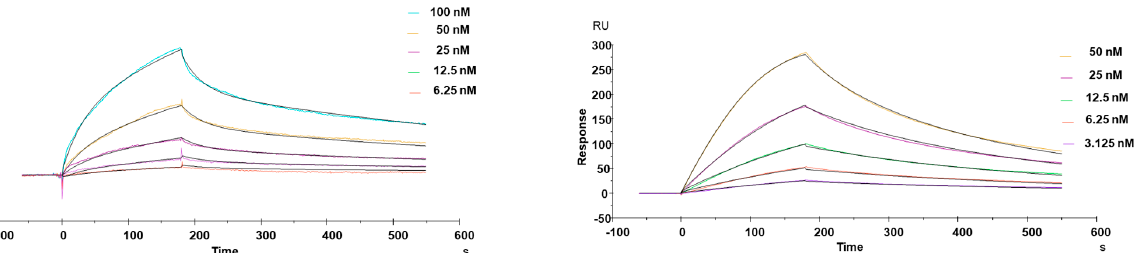
Figure 1. Summary of 3a antibodies characterization. ( A ) Western blot analysis of N3aB02 and 3aCA03 scAbs binding to ORF3a cell lysate (+ ORF3a transfected HEK293T cells; − non-transfected cells). ( B ) EC50 for N3aB02 and 3aCA03 scAbs binding to respective peptide antigens (data presented are mean +/ − SEM of three experimental replicates). ( C ) Immunofluorescence (IF) microscopy images showing binding of AF488 conjugated N3aB02 and AF647 conjugated 3aCA03 scAbs to ORF3a transfected cells in permeabilized or non-permeabilized cells (scale bar = 5 µ m). ( D ) IF microscopy images showing binding of N3aB02 and 3aCA03 scAbs to SARS-CoV-2 infected cells. FITC labelled anti-Human Kappa light chain antibody was used for fluorescent signal generation (scale bar = 12 µ m). ( E ) IF staining showing colocalization of N3aB02-AF488 and 3aCA03-AF647 scAbs in ORF3a-transfected cells (scale bar = 5 µ m). ( F ) Co-occurrence scatterplot of AF488 (N3aB02) and AF647 (3aCA03) fluorescent signals representing the degree of overlap of ORF3a N and C terminal antibodies binding in transfected cells. ( G ) SPR sensorgrams of N3aB02 scAb and N3aB02 mAb from multi cycle kinetics. Colored lines represent experimental data with different scab or mAb concentrations and black lines represent fitted